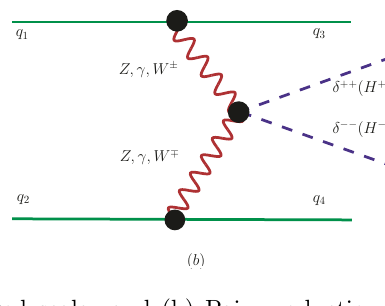
Figure 10. (a) Production of single doubly (singly) charged scalar and (b) Pair production of doubly (singly) charged scalars through Vector Boson Fusion (VBF). The [ Feynman vertex (renormalizable + corrections due to dimension-6